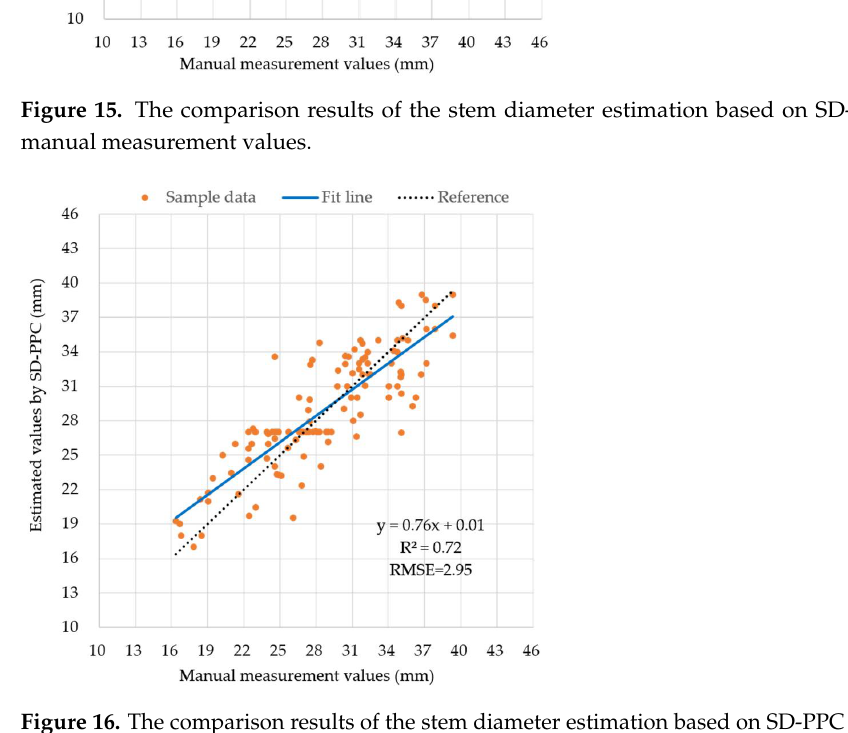
Figure 16. The comparison results of the stem diameter estimation based on SD-PPC and the manual measurement values.